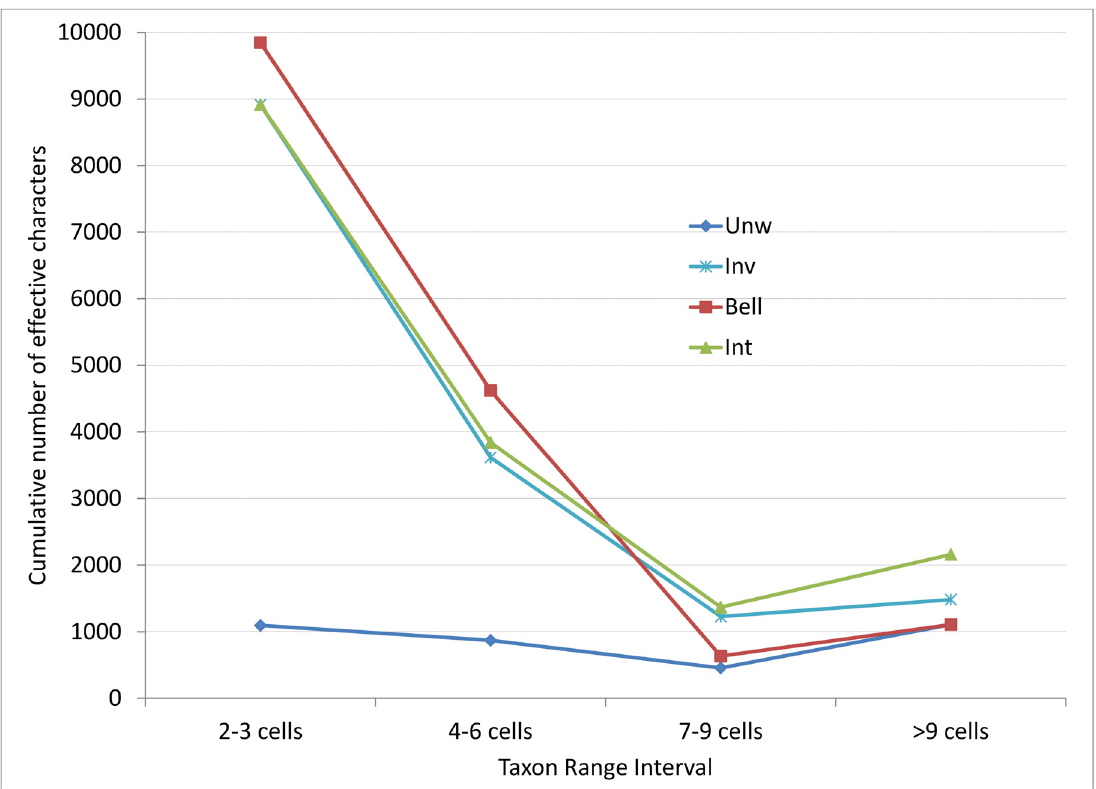
Fig 4. The bin frequency distributions of weighted matrix characters generated by the different weighting techniques. Taxa restricted to a single cell were excluded as they are not effective for clustering. Total site taxon matrix character numbers are reported in Table 2.